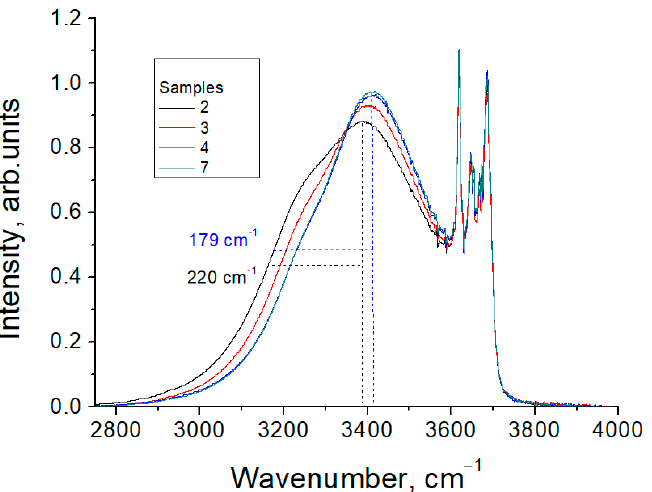
Figure 4. Regions of the IR spectra of samples 2, 3, 4, and 7 at a moisture of 26%. The left parts of the band widths (horizontal dashed lines) of samples 2 and 4 at half peak intensity are indicated.